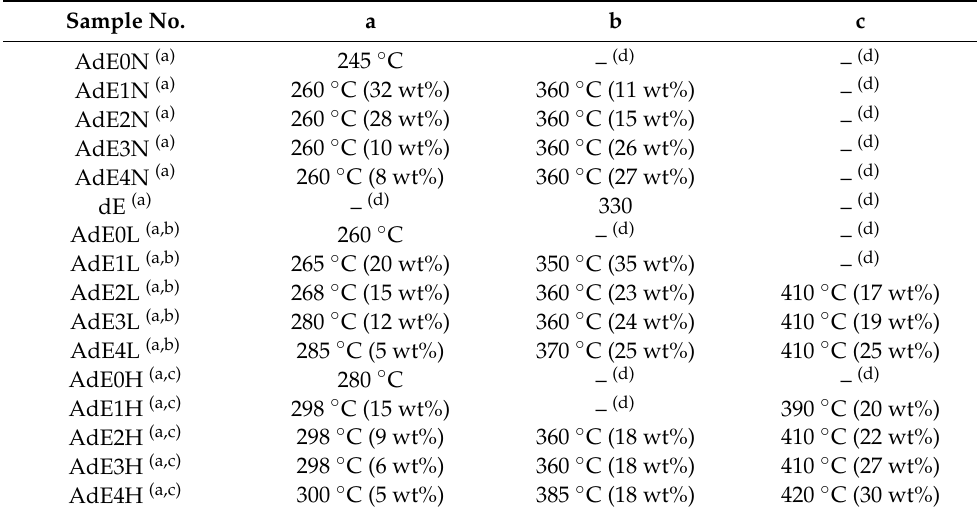
Table 2. TGA analysis of ALG/dECM composite scaffold membranes. Sample